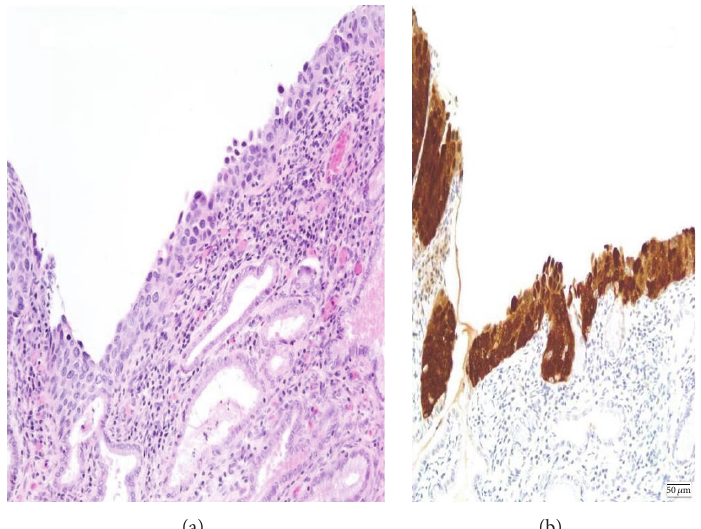
Figure 1: Typical example of CIN2/3 lesion HPV-negative (H&E) (a). Note the strong nuclear positivity for p16 protein (b).